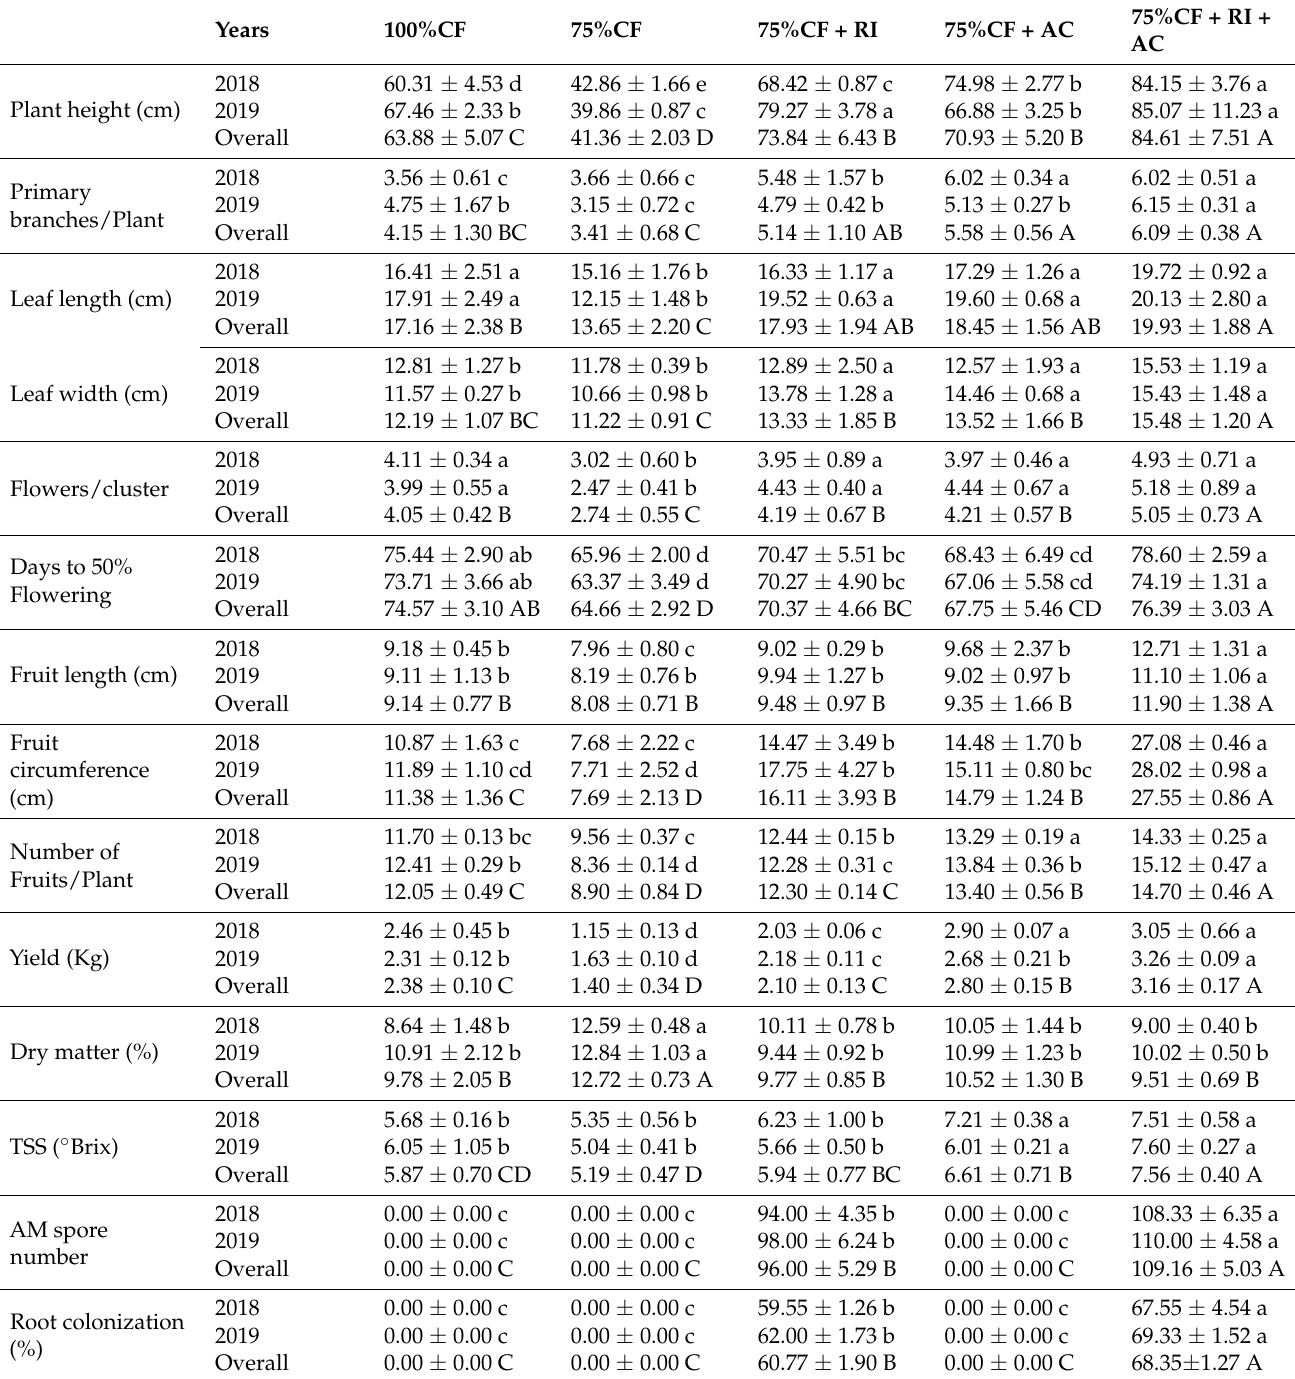
Table 2. Effects of different treatments on morphological and biochemical traits of the